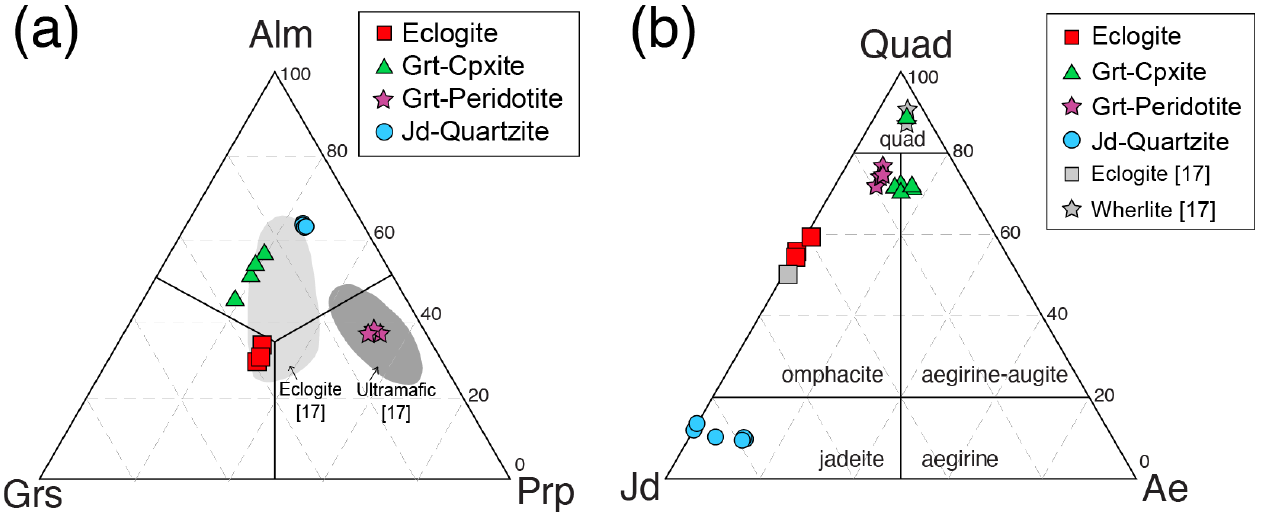
Figure 6. ( a ) Chemical compositions of garnet. Gray areas represent garnets in eclogite and ultramafic samples from the Bixiling complex reported by Zhang et al. [17]. ( b ) Chemical compositions of clinopyroxene. Gray symbols represent clinopyroxenes in eclogite and wherlite from the Bixiling complex reported by Zhang et al. [17]. Alm, almandine; Grs, grossular; Prp, pyrope, Quad, quadruplet pyroxenes that is the field of the clinopyroxenes classified in the Ca-Mg-Fe diagram; Jd, jadeite; Ae, aegirine.